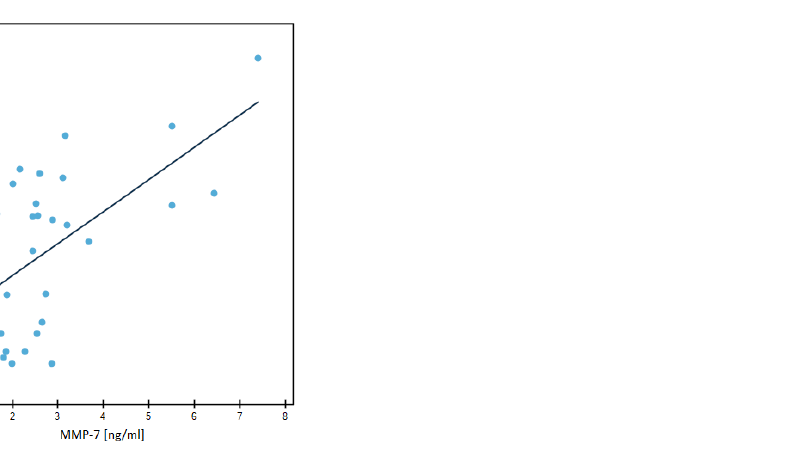
Figure 8. Significant correlations by Spearman’s method between MMP-3 and MMP-7 3 in Luminal B HER2-negative subgroup. Table 4. The Spearman’s rank correlation test for MMP-3, MMP-7 and CA 15-3 in BC group of pa- tients (total group and subgroups) and control groups.